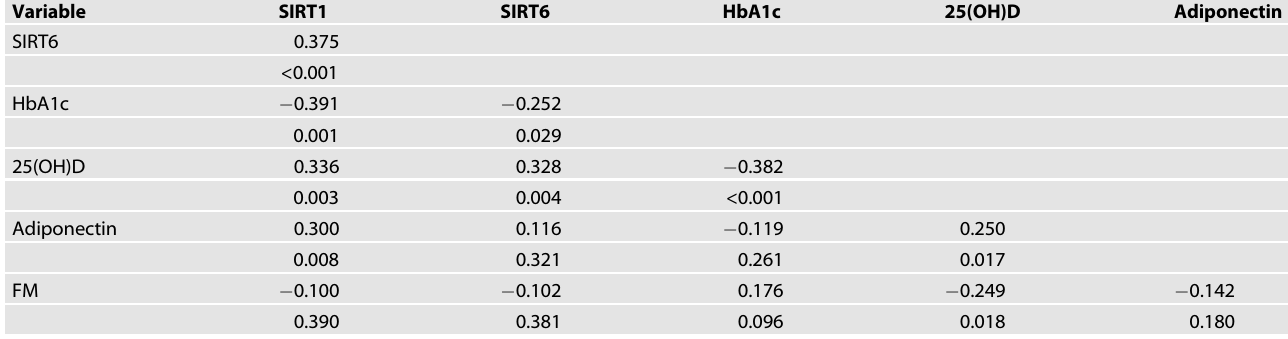
Table 3. The results of Pearson correlation analysis between changes of the studied variables.